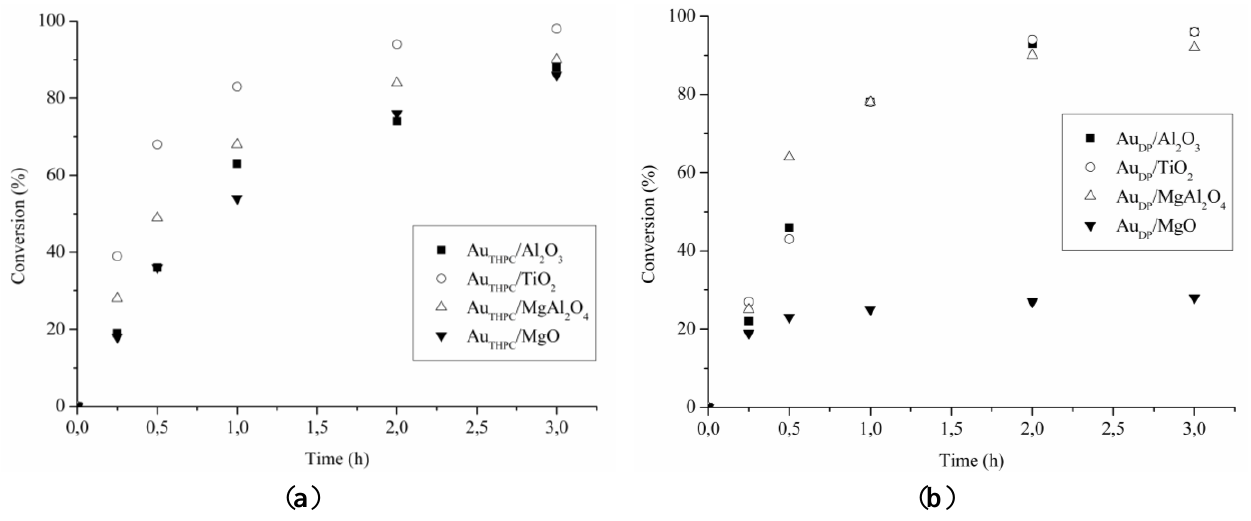
; and ( b ) Au THPC DP